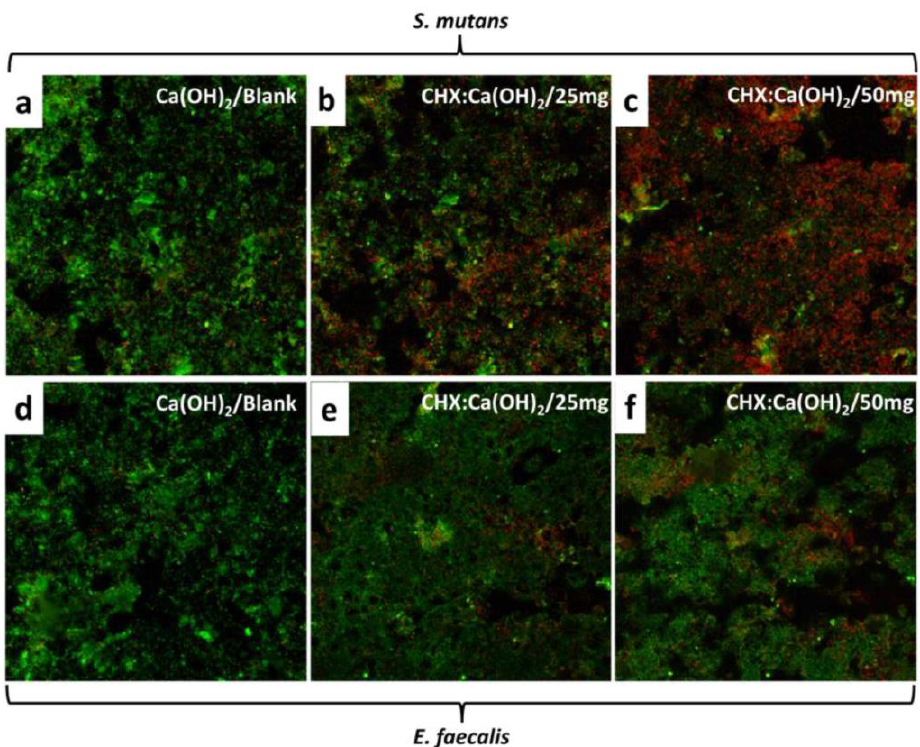
Figure 8. Selected confocal microscopy images showing Live/Dead assay of ( a – c ) S. mutans and ( d – f